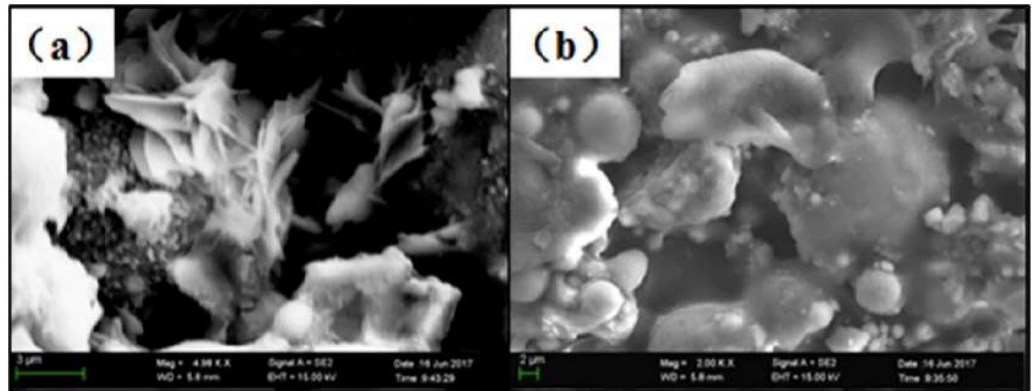
Figure 18. SEM image of fireproof material: ( a ) Hydrated product; ( b ) polymer film [74].